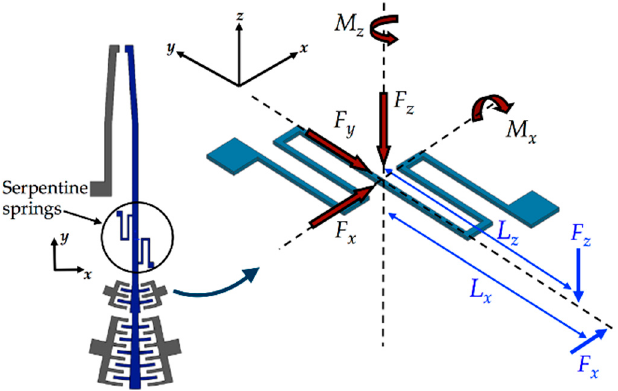
Figure 10. Schematic diagram of the forces applied on the serpentine springs of the mobile arm of the microgripper.